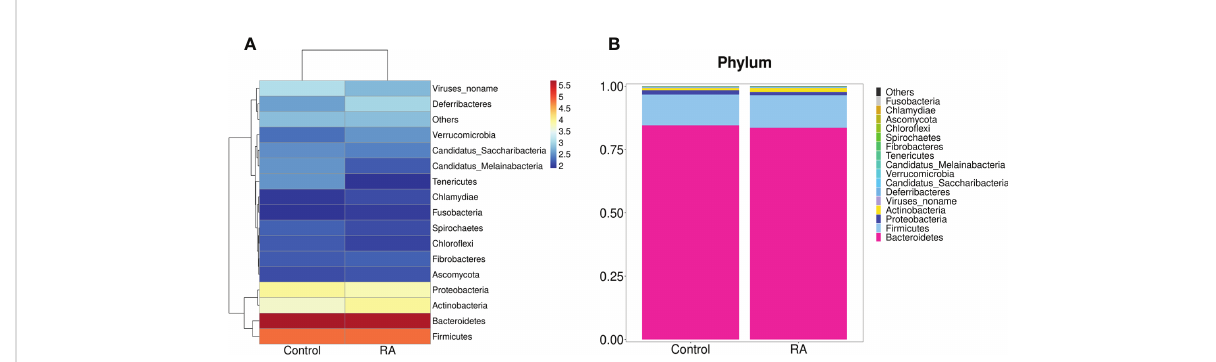
FIGURE 3 Gut microbiome structure analysis. Component proportions of bacterial phylum in the RA and control groups by heatmap (A) and stacked bar (B) ; n=5 for the RA group and n=5 for the control group.